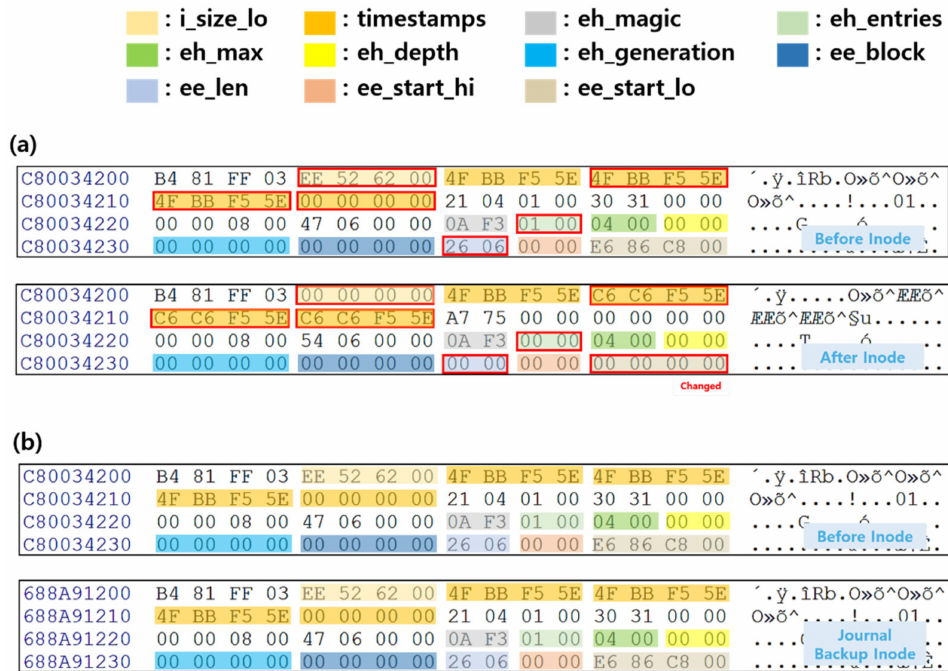
Figure 4. Metadata analysis of filesystem before and after app data deletion using scenario I ( a ) Comparison of image1.jpg’s inode before and after deleting app data ( b ) Comparison of im- age1.jpg’s inode before deletion and journal backup inode the name of the journal file of the database. The red box indicates changed fields before and after